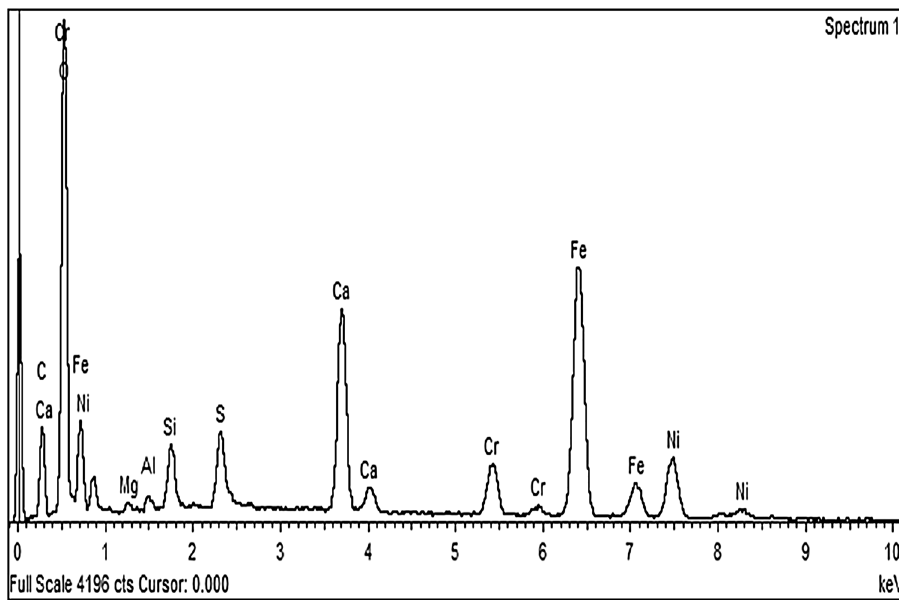
Fig. 2 EDS composition analy- sis of water mix (1:1) showing different elements (Fe, Ca, Ni, Cr,